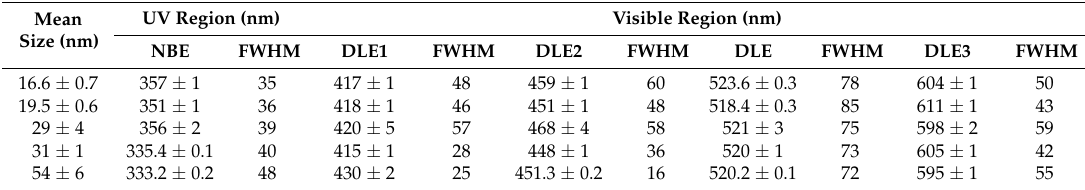
Table 2. Summary of Voigt distribution function fitting parameters for PL spectra of NiO